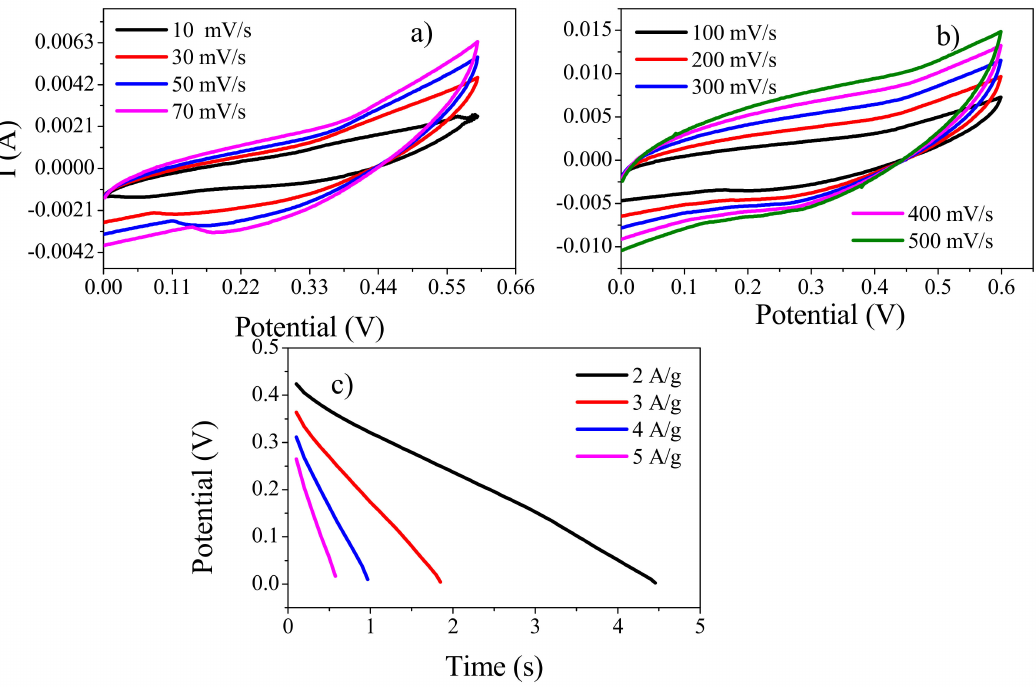
Figure 13. ( a ) CVs of a solid-state symmetric device (fabricated with copper as current collector) at lower scan rates (10, 30, 50, and 70 mV / s) and ( b ) higher scan rates (100, 200, 300, 400, and 500 mV / s). ( c ) Discharge curve of the same device at di ff erent current densities using copper as current